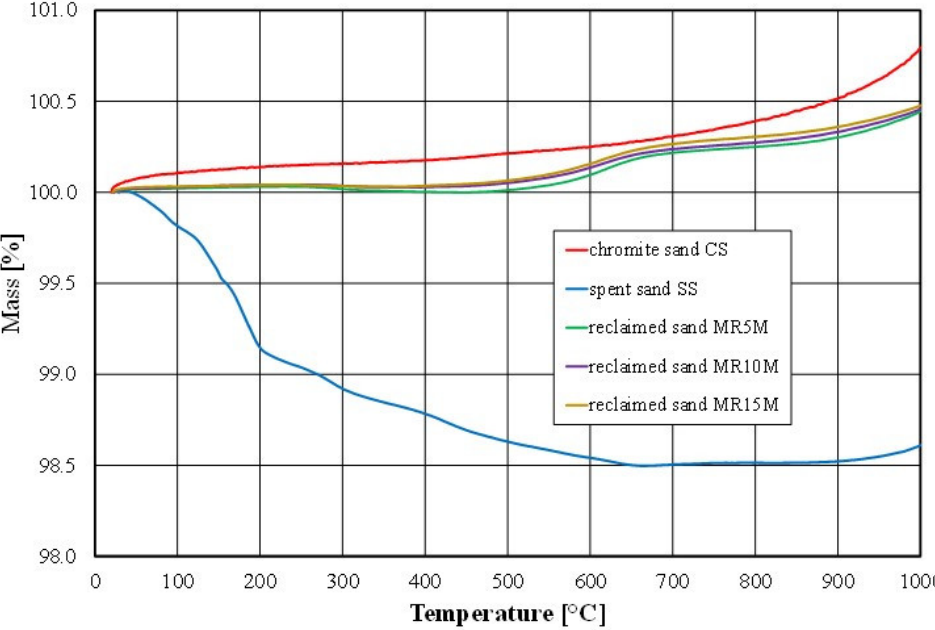
Figure 14. Thermogravimetric analysis of tested materials.